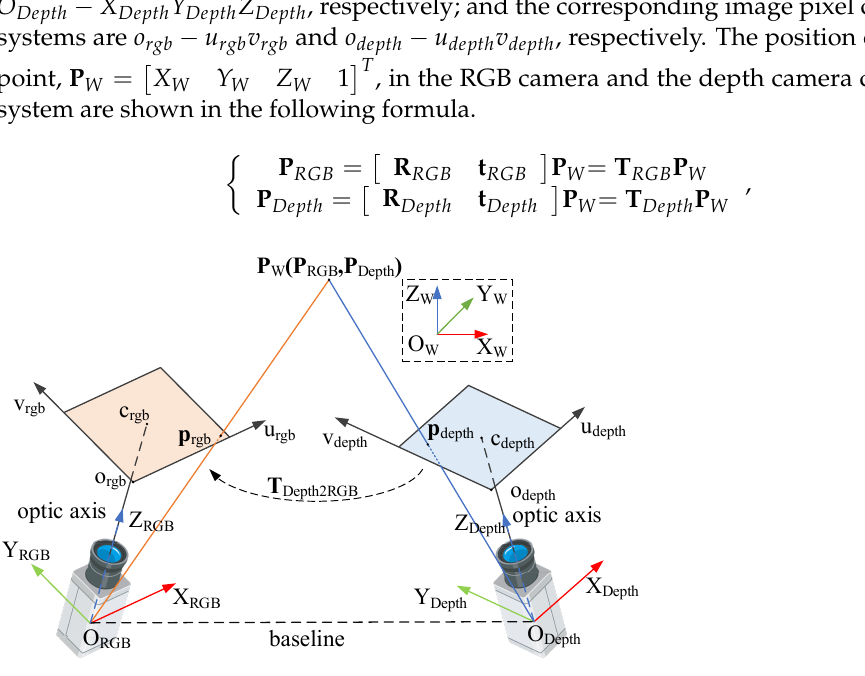
Figure 2. The schematic diagram of the RGB-D coordinate system.